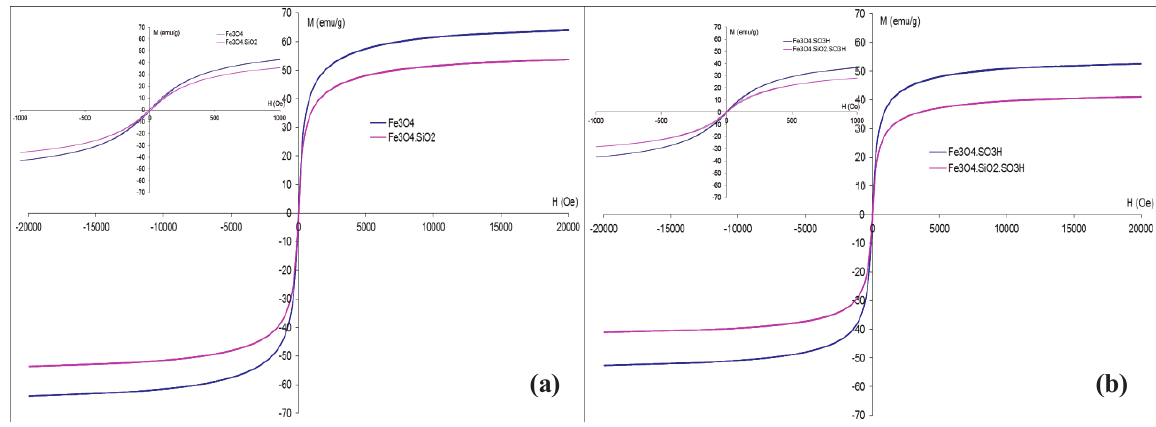
O .S i O .SO H samples (b) a t room t empera t ure ( - 1000 3 4 2 3